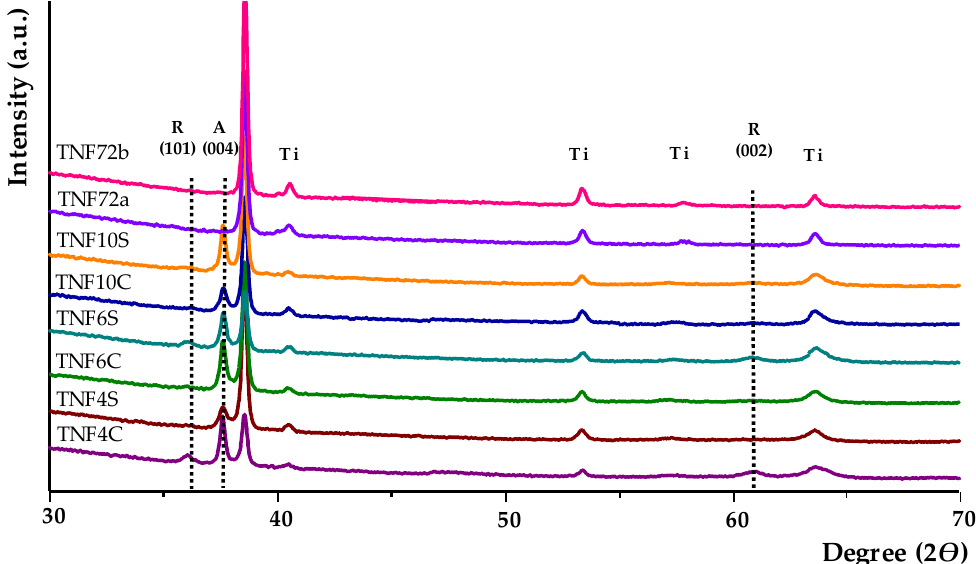
Figure 2. X-ray diffraction spectra of produced Ti6Al4V/TNF samples (lines marked as Ti are assigned Figure 2. X-ray di ff raction spectra of produced Ti6Al4V / TNF samples (lines marked as Ti are assigned to the titanium of titanium alloy substrate). to the titanium of titanium alloy